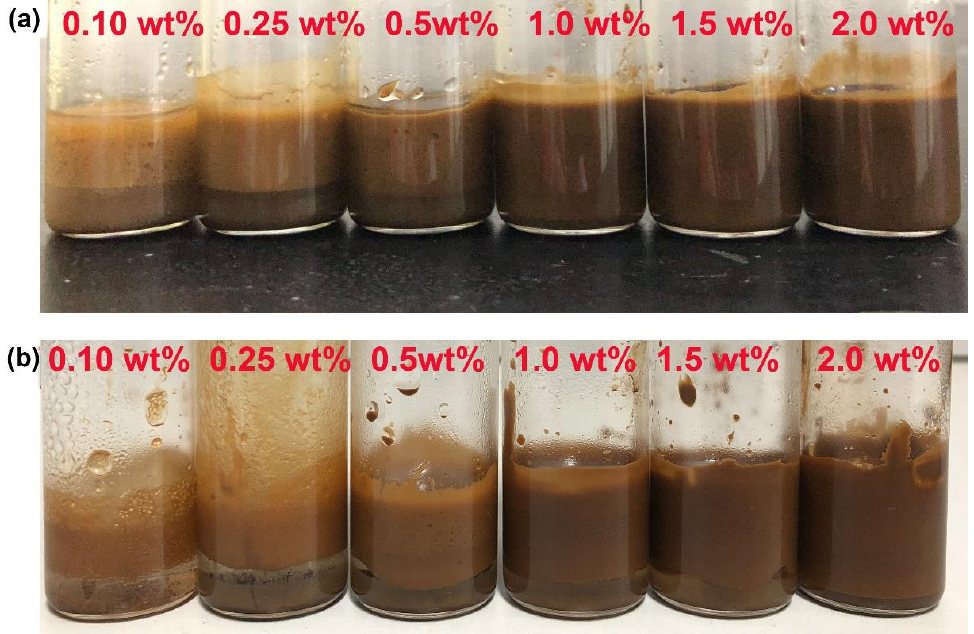
Figure 5. Photographs of the oil-in-water Pickering emulsions stabilized by DC-Fe 3 O 4 nanoparticles at different concentrations. The photographs were taken at 24 h ( a ) and 1 month ( b ) after the sample preparation. The liquid paraffin and water were in an equal volume ratio. Concentrations of DC-Fe 3 O 4 (wt%) in the Pickering emulsions are shown on the vessels.